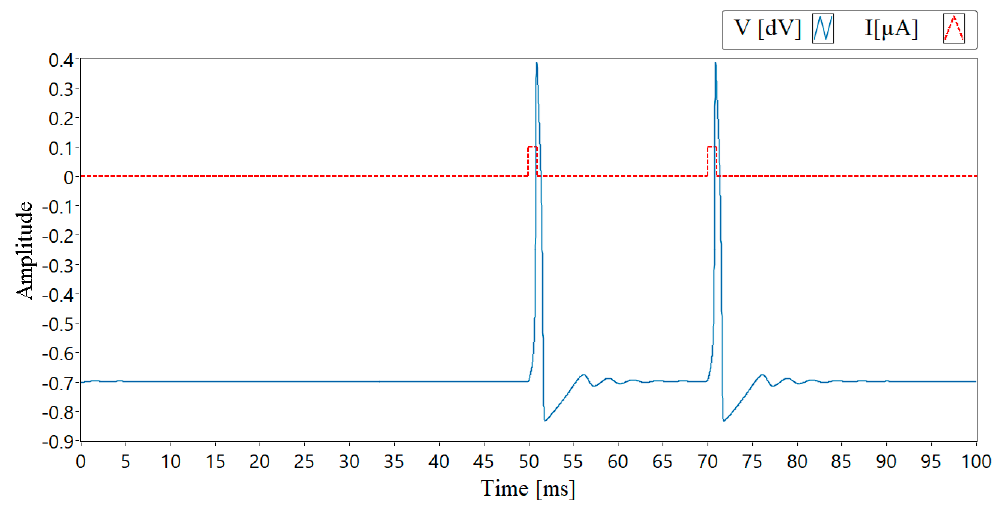
Figure 6. Input and output signals generated during refractory analysis of system (1).